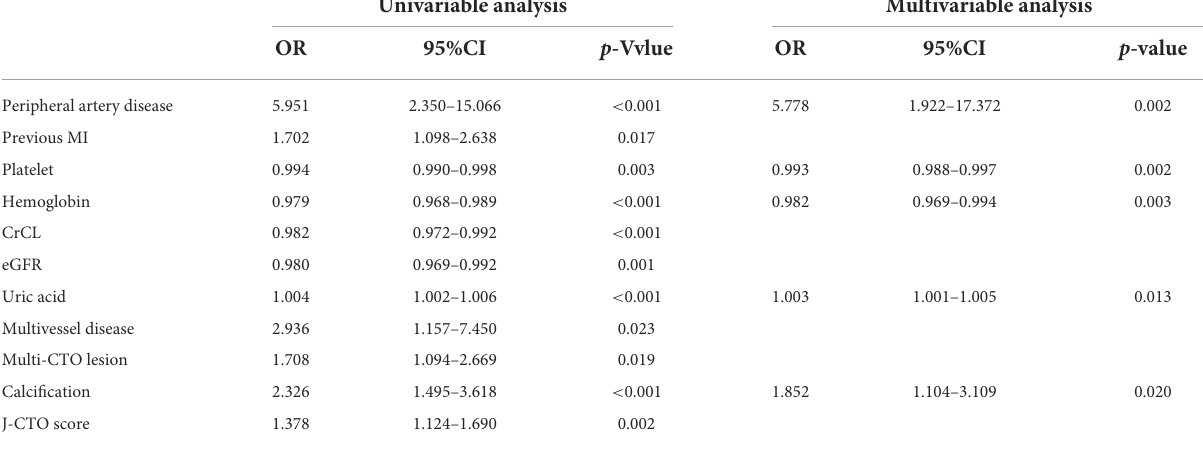
TABLE 4 Univariable and multivariable logistic regression for in-hospital complications in patients with low eGFR ( < 90 mL/min/1.73 m 2 ) after successful CTO-PCI. Univariable analysis Multivariable analysis OR 95%CI p -Vvlue OR 95%CI p -value